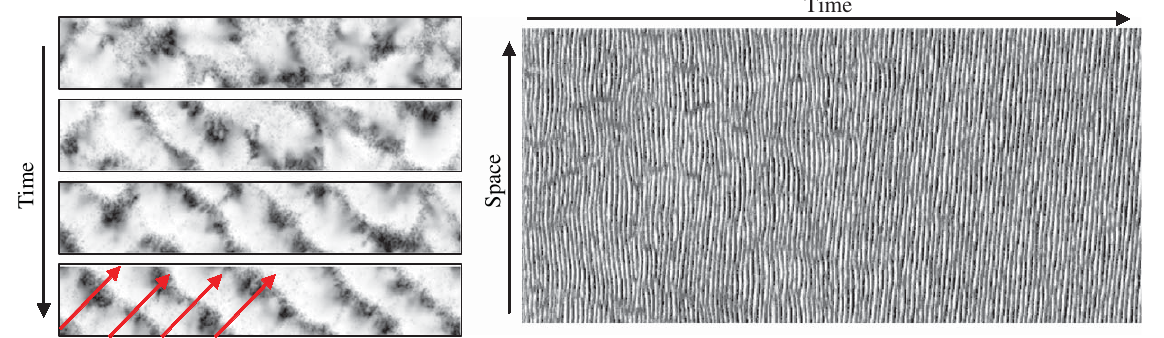
Fig. 15. Helical transport in non-patterned environment with periodic boundary conditions. Left: Snapshots of competition and entrainment of wavefronts with final helical-type movement arrowed, Right: Space-time plot showing long period before regular transport occurs.